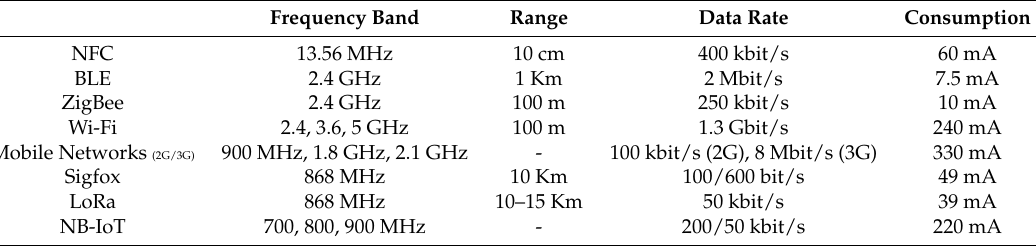
Table 1. Comparison between communication